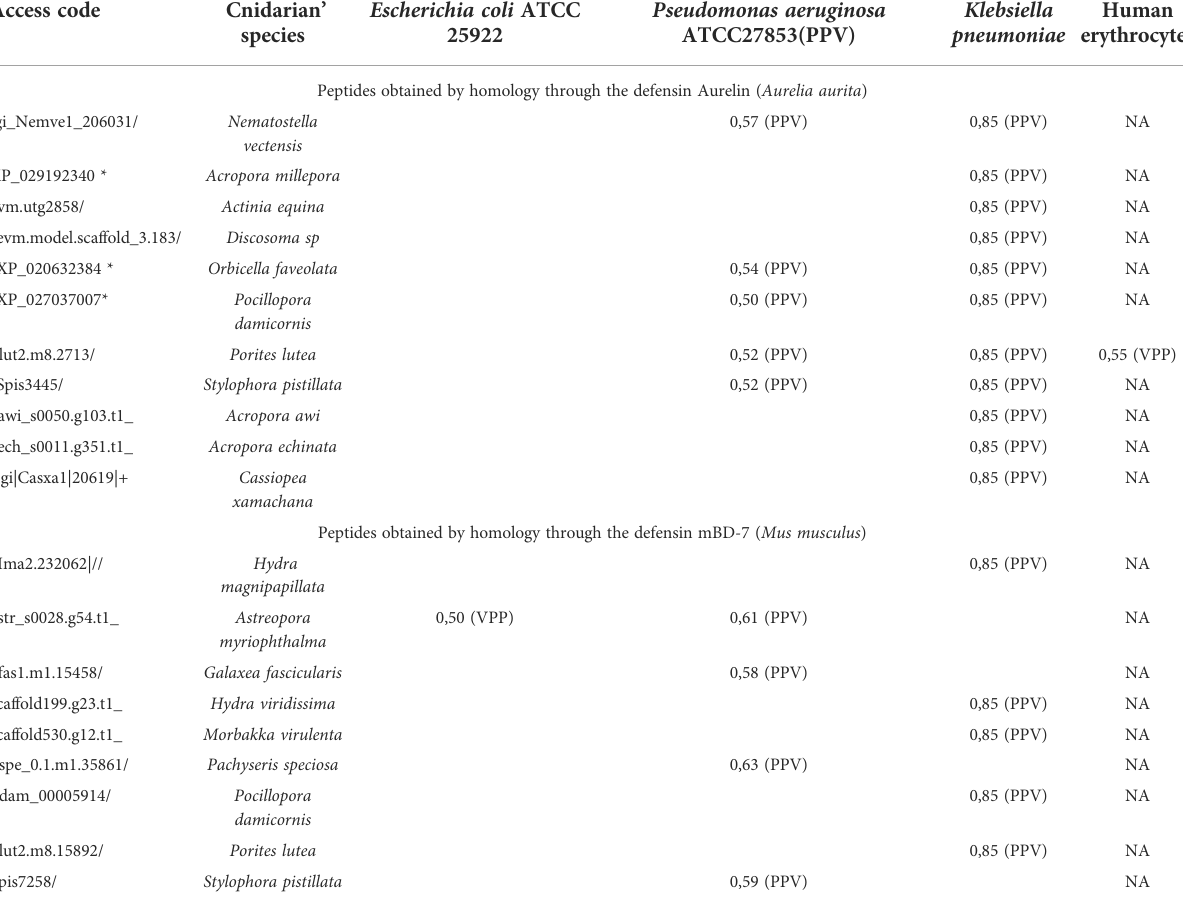
TABLE 4 Putative activity antimicrobial of the Cnidarian ’ s AMPs. Access